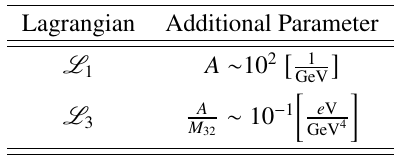
Table 2. The table below shows the bounds on the additional parameters. These bounds are calculated from the experimentally determined range of ∆ m 2